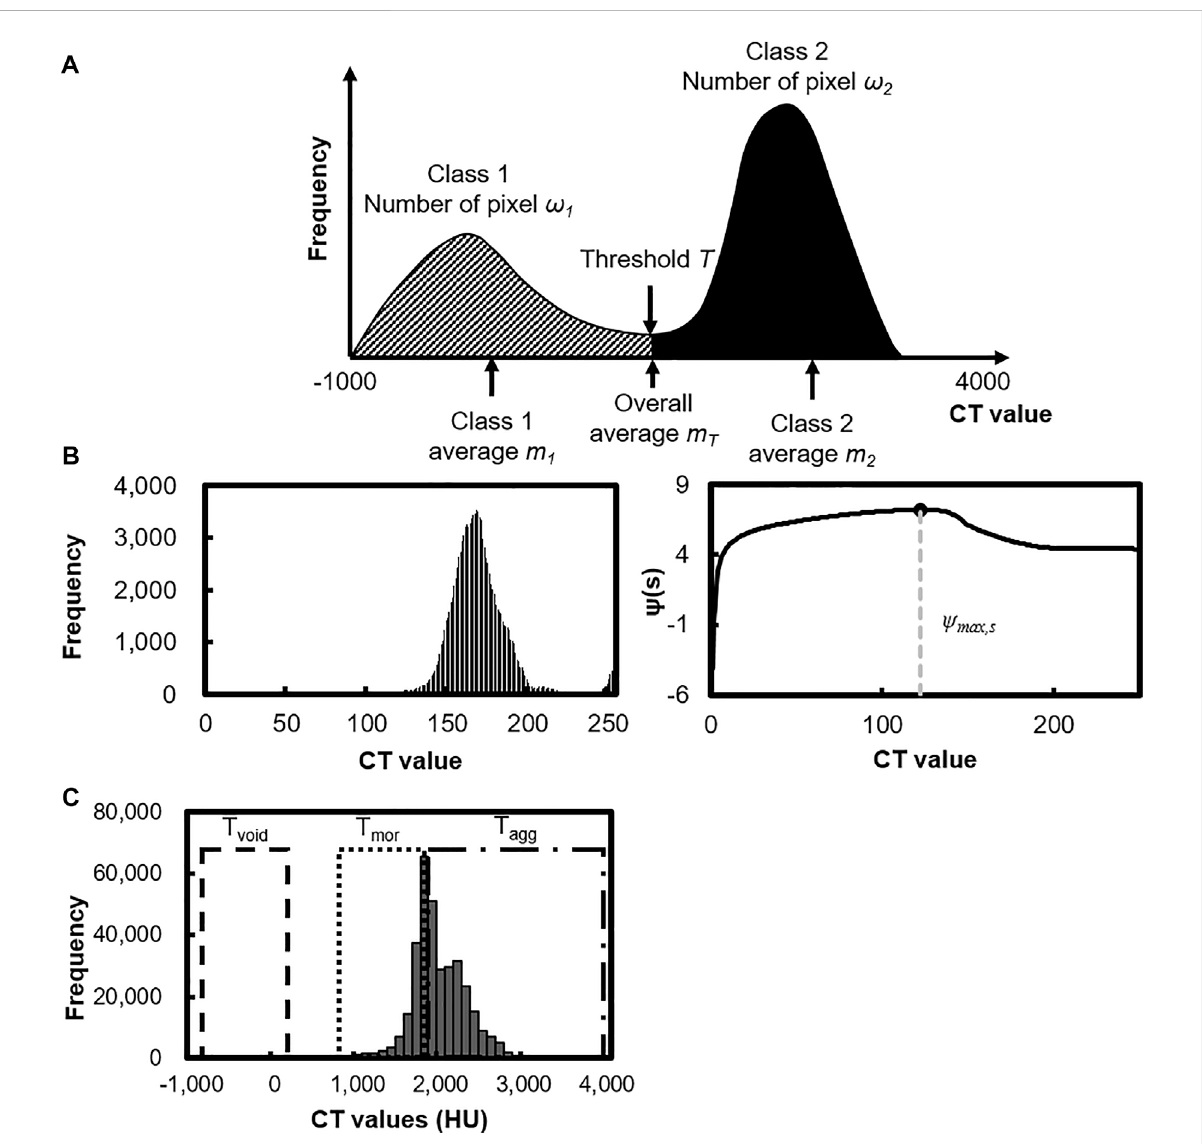
FIGURE 3 Otsu and Max entropy methods. (A) Determination of threshold by discriminant analysis method. (B) Histogram and binarization by maximum entropy method. (C) Histogram of CT values and threshold.